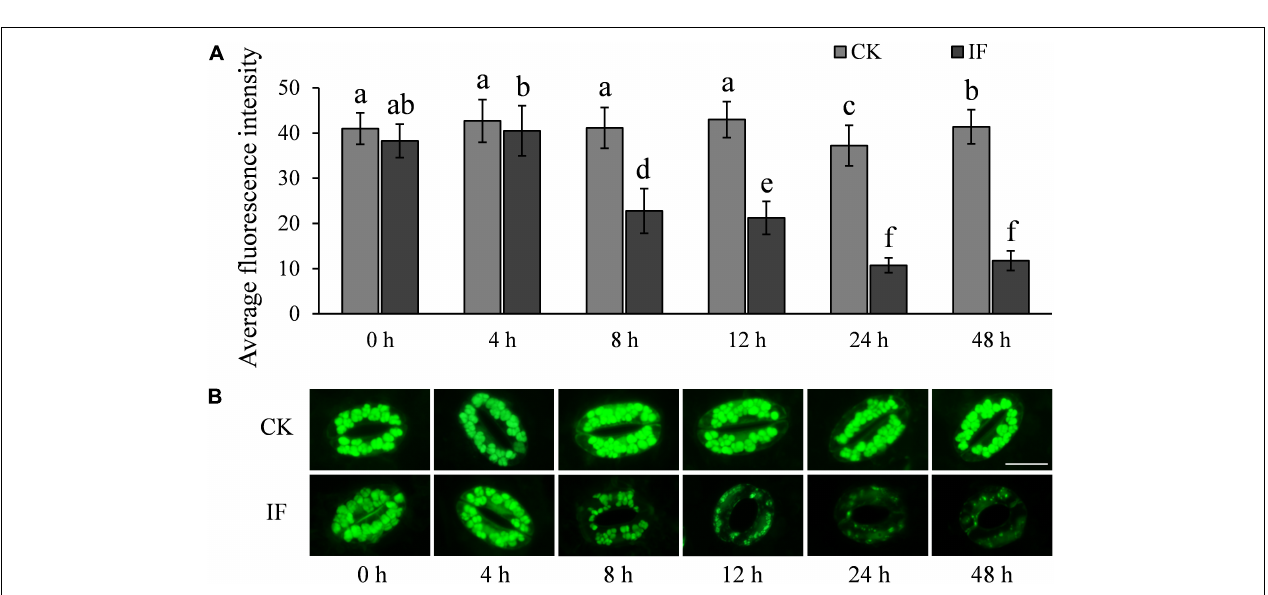
FIGURE 7 | H 2 O 2 accumulation changes in guard cells during P. infestans infection: (A) H 2 O 2 dynamics in the P. infestans -infected (IF) and non-infected (CK) potato guard cells; and (B) images showing the fluorescence intensity of H2-DCFDA in IF and CK potato guard cells. The marker = 20 µ m. Photos within a panel are from a representative of a single replicate while photos among panels are pooled from multiple replicates.